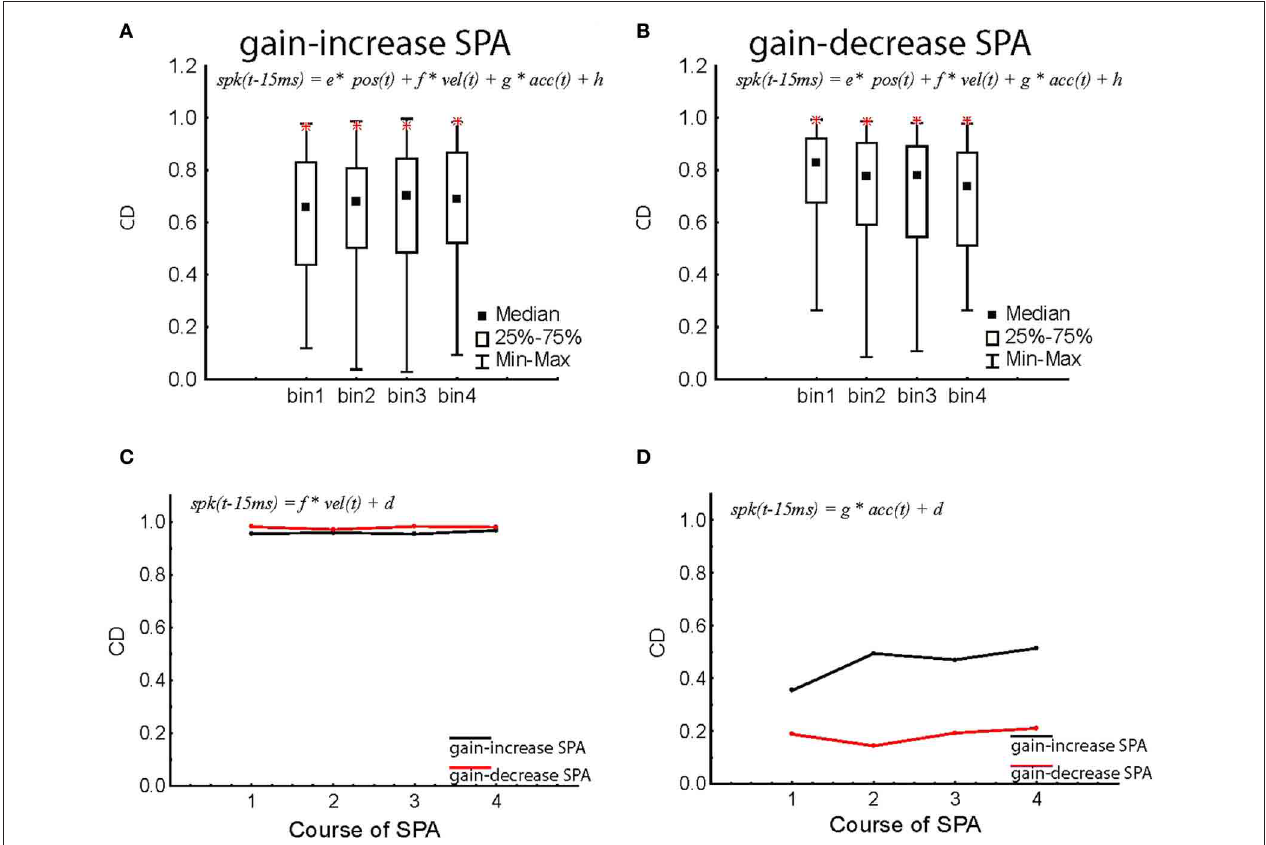
course. Note that the CDs for the population response are much larger than the vast majority of individual PC SS. (C,D) Degraded regression models restricted to eye velocity (C) and eye acceleration (D) respectively as function of the four bins characterizing the course of SPA.The population response was based on all PC SS,independent of response type. The CDs of gain-increase SPAare shown in black, the ones for gain-decrease SPAin red. Allthe CDs computed in this figure are for (cid:2) =